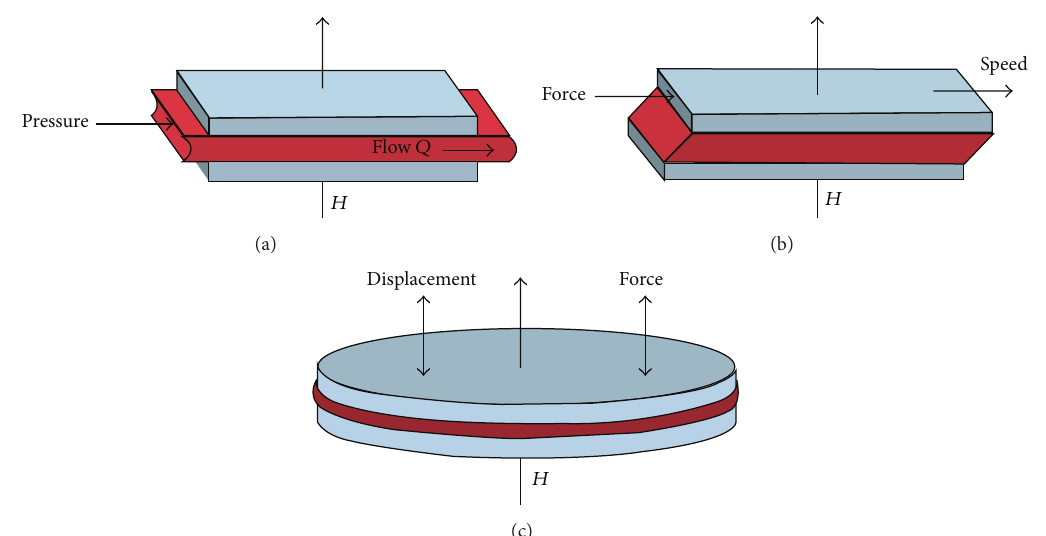
Figure 15: MR fluid operational modes [15]: (a) the flow mode, (b) the direct shear mode, and (c) the squeeze mode.